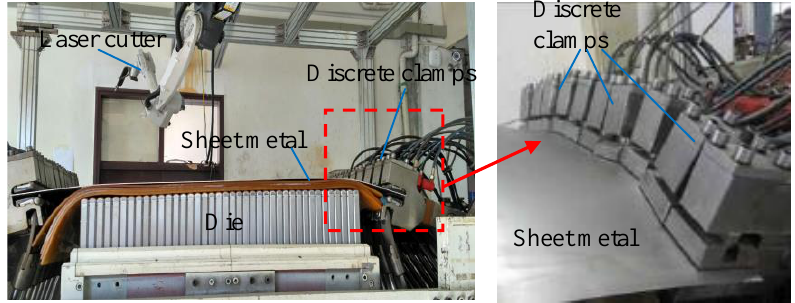
Figure 15. Equipment of stretch-forming process based on loading at multi-positions.